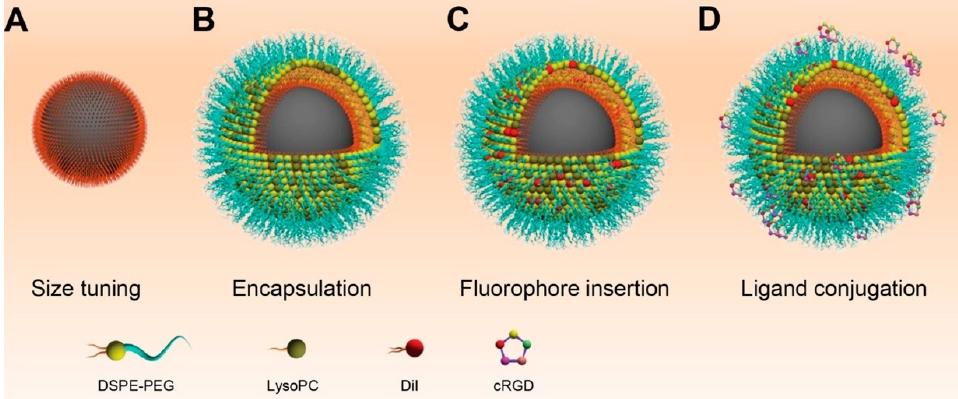
Figure 28. Illustrated design of lipid-encapsulated organic dye-doped polymer-coated iron oxide MNPs for dual-MRI and FI. Reproduced with permission from reference [15]. Copyright 2020 American Chemical Society.